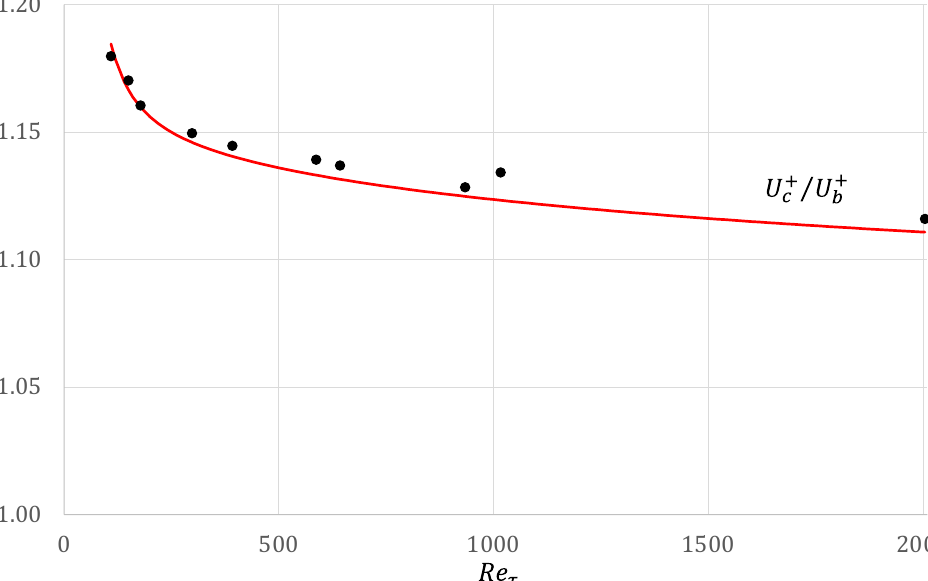
Figure 4. Trend of the skin friction based on the mean velocity 𝐶𝐶 𝑓𝑓 �𝑈𝑈 𝑏𝑏+ � = 2 �𝑈𝑈 𝑏𝑏+ � 2 ⁄ and of the skin friction based on the centerline velocity 𝐶𝐶 𝑓𝑓 �𝑈𝑈 c+ � = 2 �𝑈𝑈 c+ � 2 ⁄ ; • DNS data; and ─ ITM.